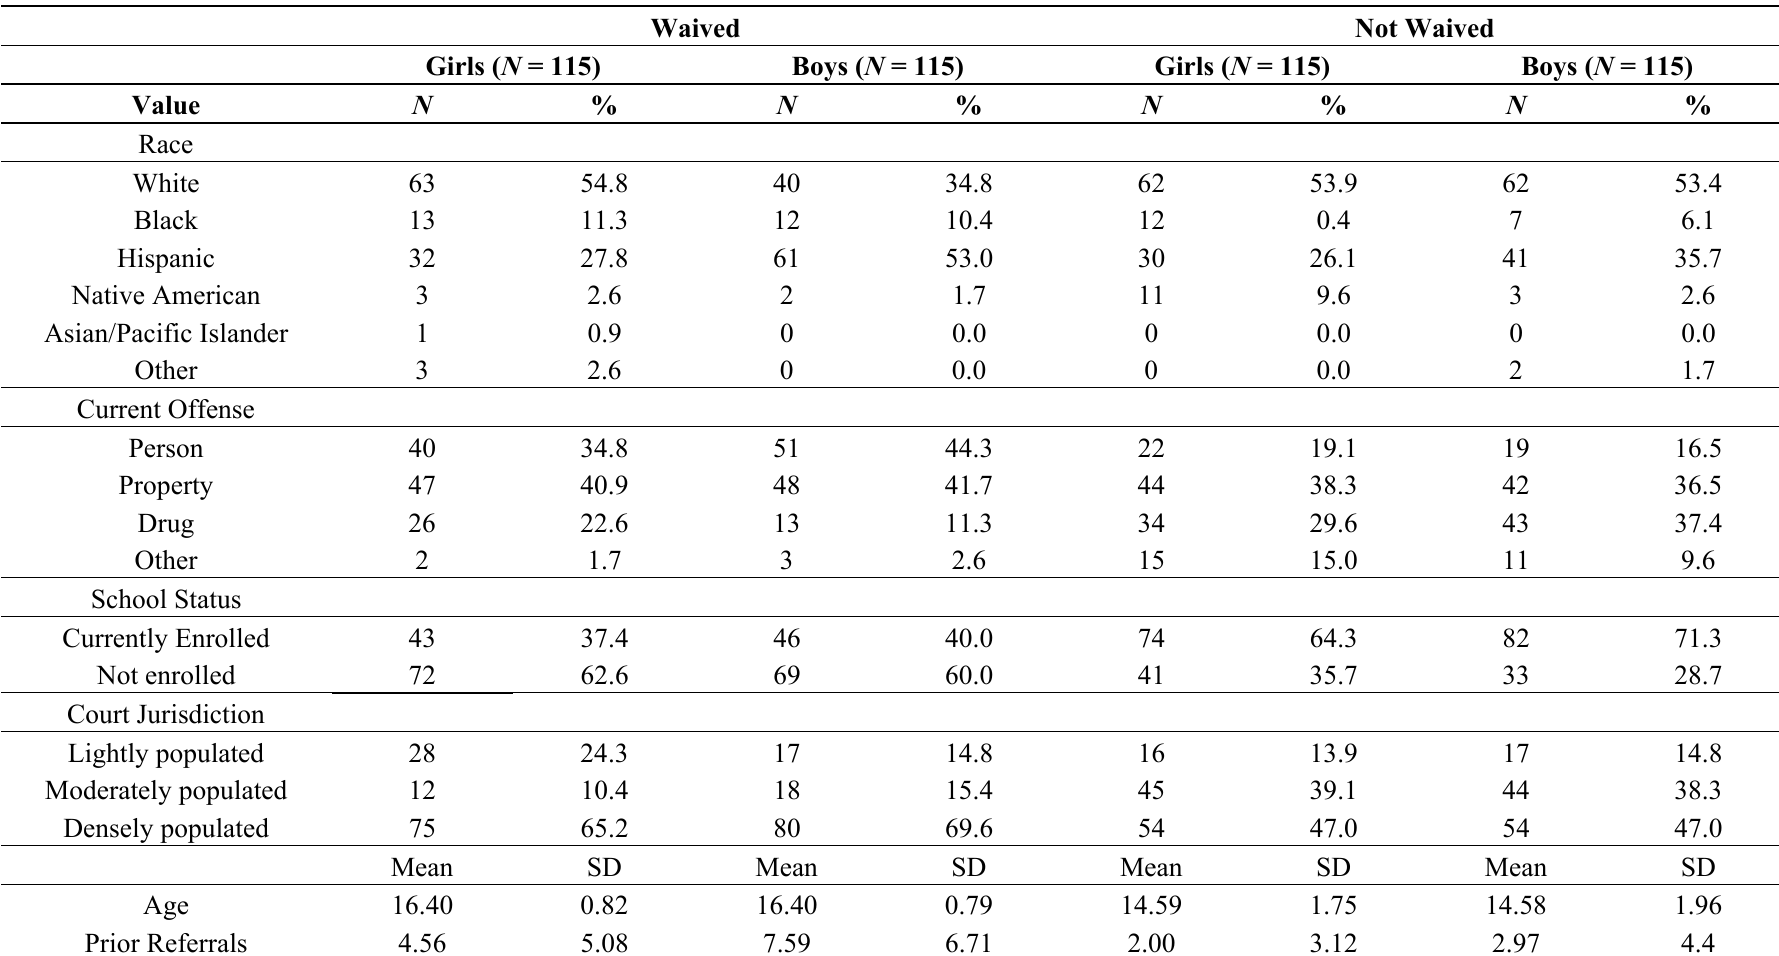
Table 1. Frequency Distribution of Variables for Girls and